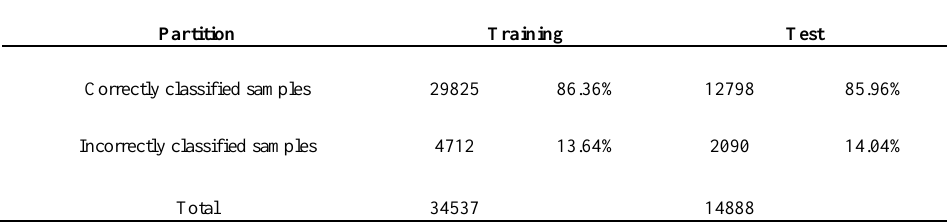
Table 5. Accuracy of decision tree of ATM transactions regardless of month and year.